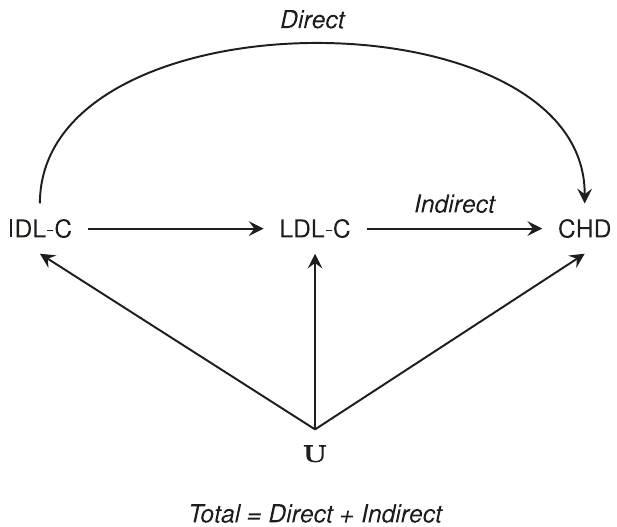
Fig. 1 Illustrating the difference between total, direct, and indirect effects, using a hypothetical diagram of intermediate-density lipoprotein cholesterol, low-density lipoprotein cholesterol and coronary heart disease. IDL-C intermediate-density lipoprotein cholesterol, LDL-C low- density lipoprotein cholesterol, CHD coronary heart disease, and common causes (confounders) represented by U